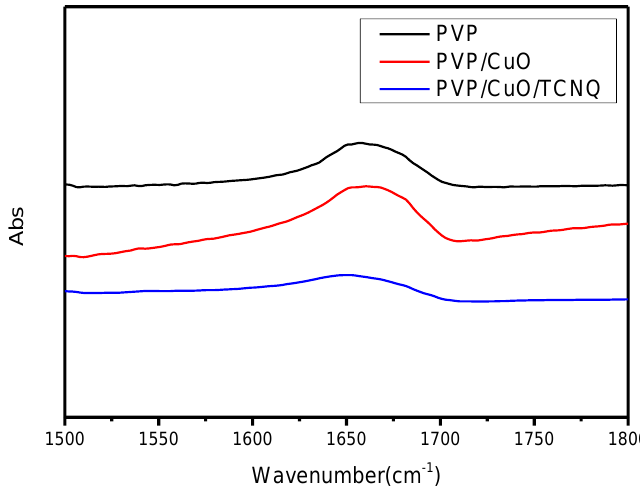
Figure 2. IR spectra of PVP, PVP/CuO, and PVP/CuO/TCNQ composites.